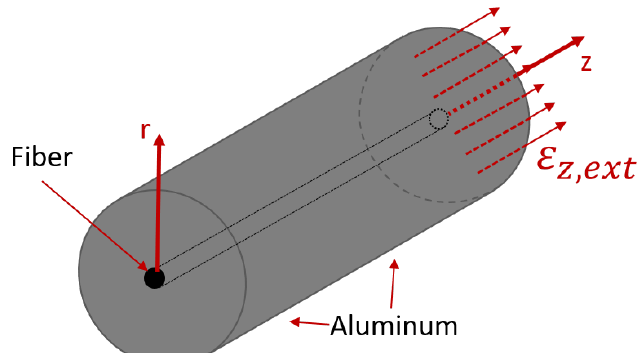
Figure 3. Schematic layout of the embedded fiber in aluminum with applied external axial strain, ε z , ext , acting on both the fiber and the